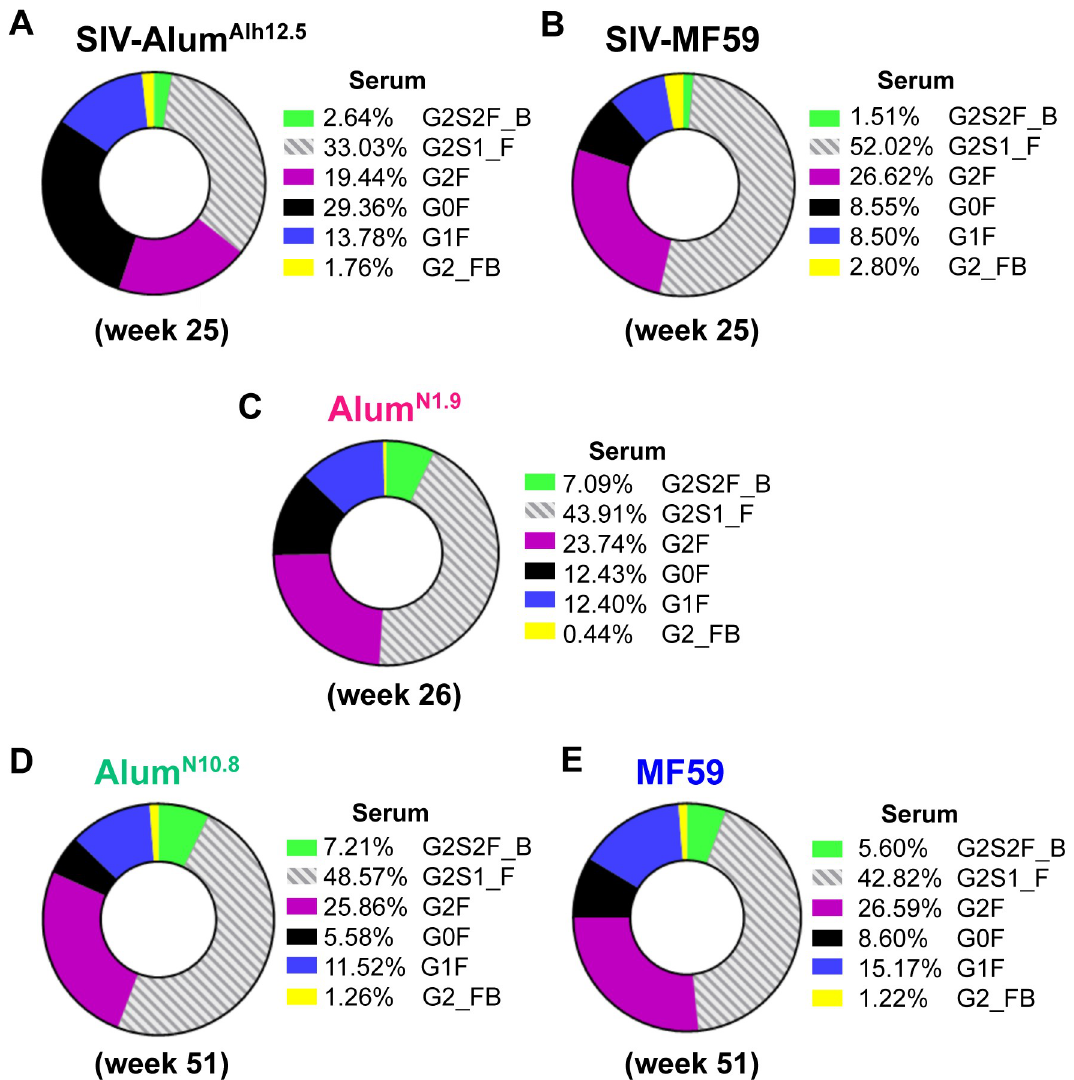
Fig 5. Anti-gp120 antibody glycoforms in serum of SIV and SHIV studies using MF59, Alum Alh , or Alum N adjuvants. Anti- gp120 antibody glycoforms in vaccinated animals: (A) SIV-Alum Alh12.5 , n = 27; (B) SIV-MF59, n = 27; (C) Alum N1.9 , n = 27; (D) Alum N10.8 , n = 8; (E) MF59, n = 8. The Fc-domain of antibodies can be classified by the presence or absence of different sugar group such as 1 fucose (“F”) group, 1 bisecting-n-acetyl glucosamine (“B”) group, up to 2 galactoses (“G0,” no galactose; “G1,” 1 galactose; “G2,” 2 galactose), or up to 2 sialic acids (“S1,” 1 sialic acid; “S2,” 2 sialic acids). Different sugar group patterns mediated or inhibited different antibody functions as described by Ackerman et al. [52].